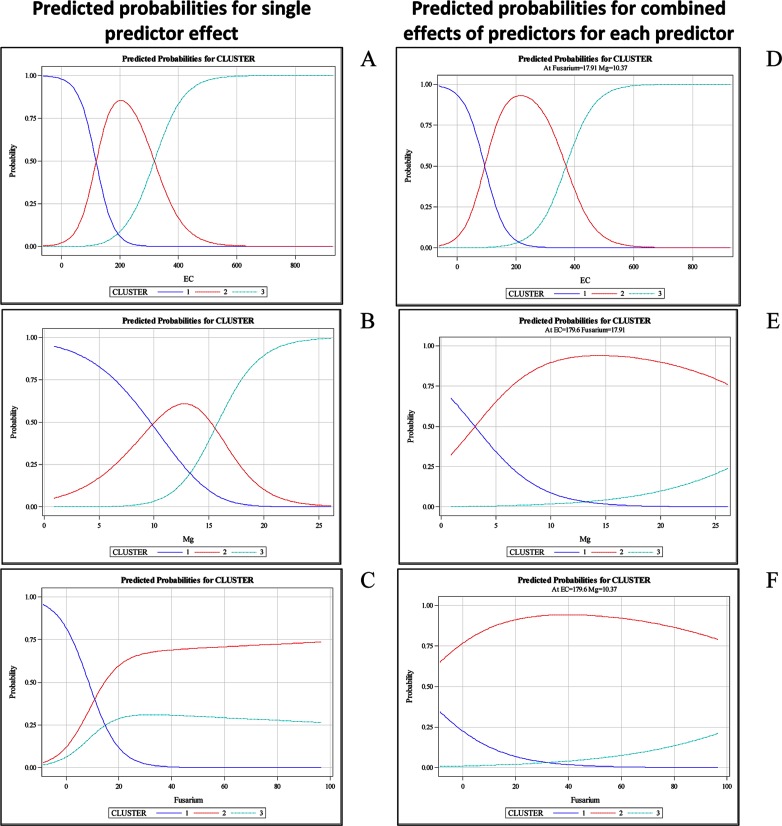
Predicted probabilities according to the multinomial logistic regression model with disease incidence as the response variable and soil biotic and abiotic parameters as explanatory variables.Left panels: (A to C) represent the predicted probability distribution curves for each single predictor (EC, Mg and Fusarium population) effect fitted separately. Right panels: (D to F) represent the predicted probabilities for each of the three parameters when the other two are fixed.